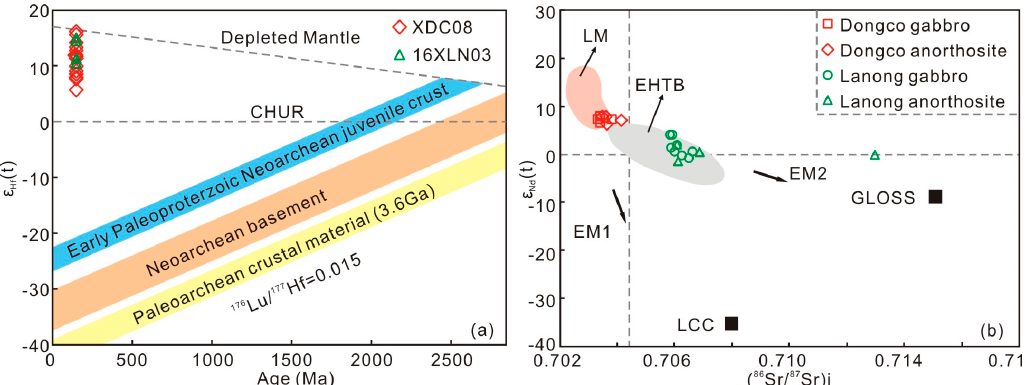
Figure 8. ( a ) Variations of U–Pb ages versus ε Hf( t ) of zircons separated from the Dongco and Lanong ophiolites. Abbreviations: CHUR, chondritic uniform reservoir. ( b ) Plots of ( 87 Sr/ 86 Sr) i – ε Nd (t) [28]. The fields of LM (lithospheric mantle) are represented by peridotite xenoliths from Cenozoic basalts in Shanwang [45] and Beiyan [46]. Data for EHTB (Emeishan high-Ti basalts) are from [47] and [48].